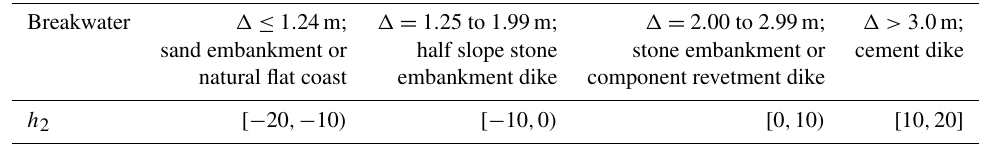
Table note: (1) The wave exposure degree of the storm-surge protection facilities depends on the degree of wave reception of the embankment, the water depth at the bottom of the embankment, and the wave height at the bottom of the embankment. (2) R is the value of the wave run-up occurring once in 2 years. There is a certain correspondence between the wave exposure degree and R . (3) The value of h 1 can be taken as 0%–15% of the R . Table 5. h 2 value (unit: cm).